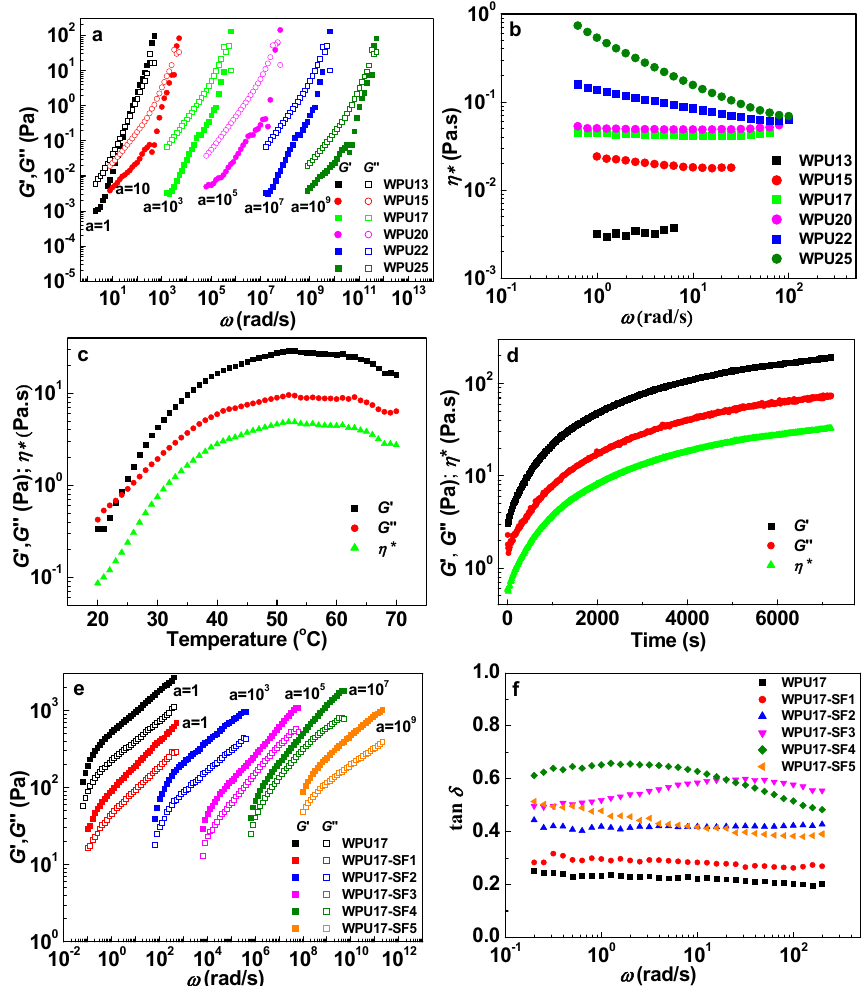
Figure 3. Dynamic rheological behavior of WPU and WPU-SF dispersions under oscillatory shear: ( a , b ) G ′ and G ′′ , and η * as a function of ω for WPU dispersions with different solid contents at T = 25 °C; ( c , d ) Temperature and time dependence of G ′ , G ′′ , and η * for the WPU17-SF5 dispersion; ( e , f ) Dynamic shear moduli, G ′ , and G ′′ , and loss tangent, tan δ as a function of ω for WPU17-SF dispersions with different silk fibroin contents at T = 37 °C. The x-axis of ( a , e ) is extended by a factors a = 1 ∼ 10 9 to obtain a valid comparison.